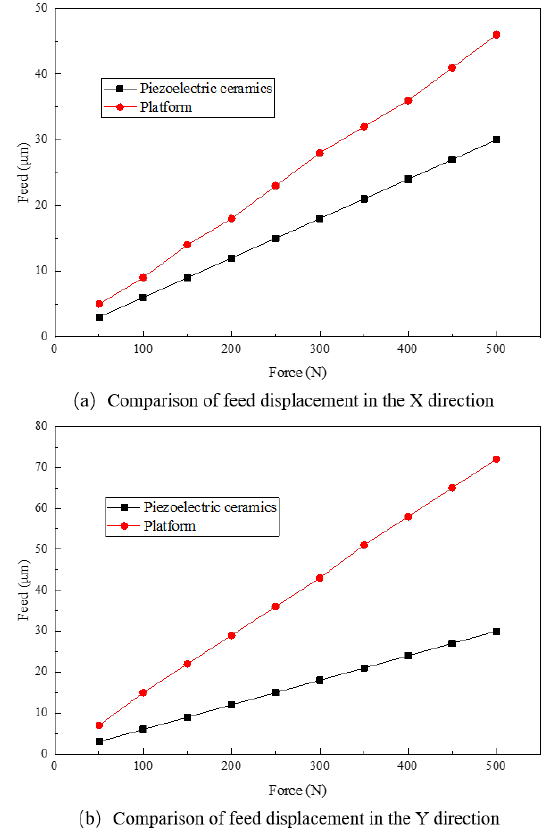
Fig. 6. Comparison of feed displacement of the